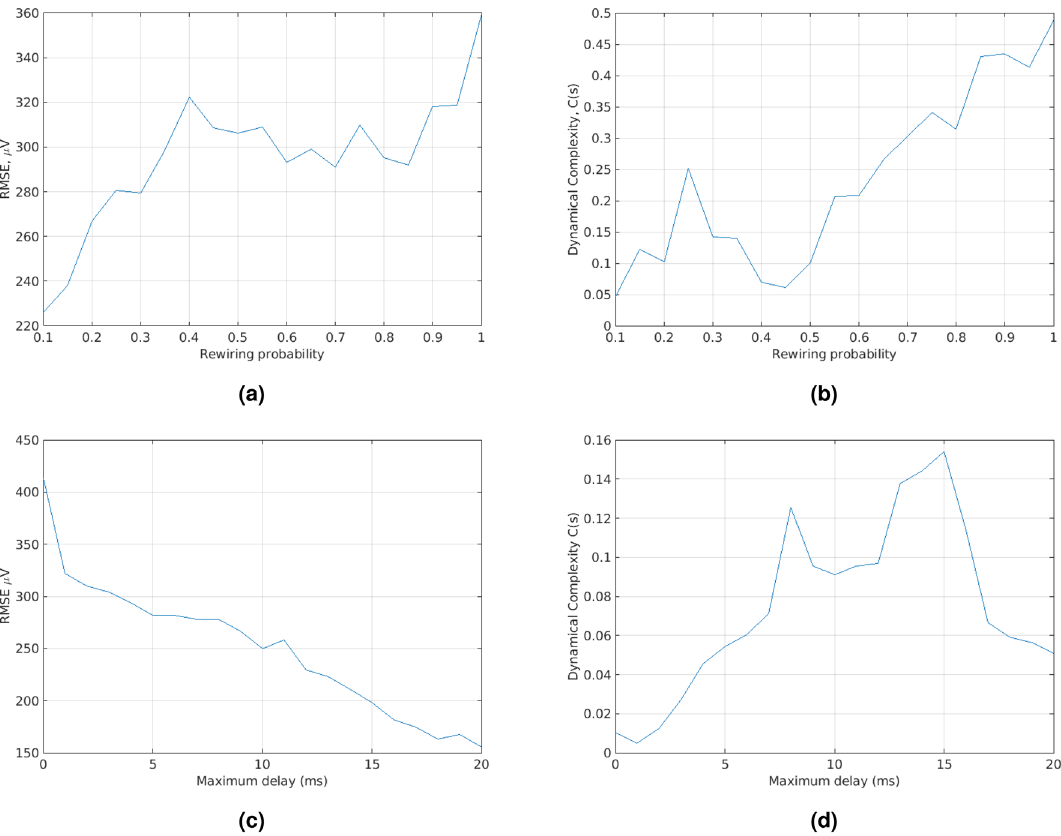
Figure 3. ( a ) Blue solid line shows RMSE with varying re-wiring probability (800 excitatory neurons and 200 inhibitory neurons). ( b ) Blue solid line Dynamical Complexity with varying re-wiring probability (800 excitatory neurons and 200 inhibitory neurons). ( c ) Blue solid line shows varying conductance delay and assessing RMSE. ( d ) Blue solid line shows varying conductance delay and assessing dynamical